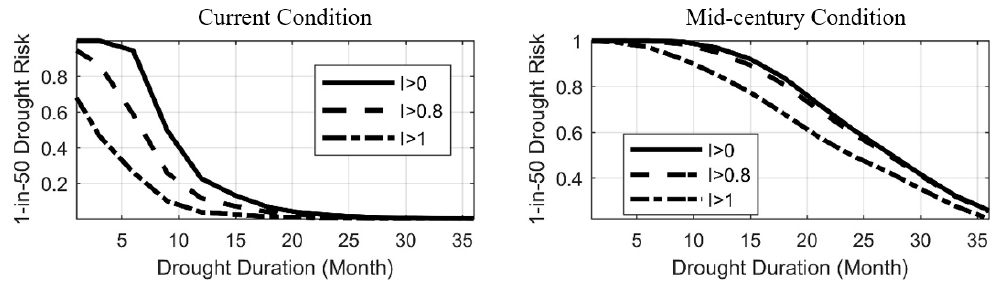
Figure 14. 1-in-50 year drought risk for current condition (left) and middle of century (right) (intensity is in mcm/month).